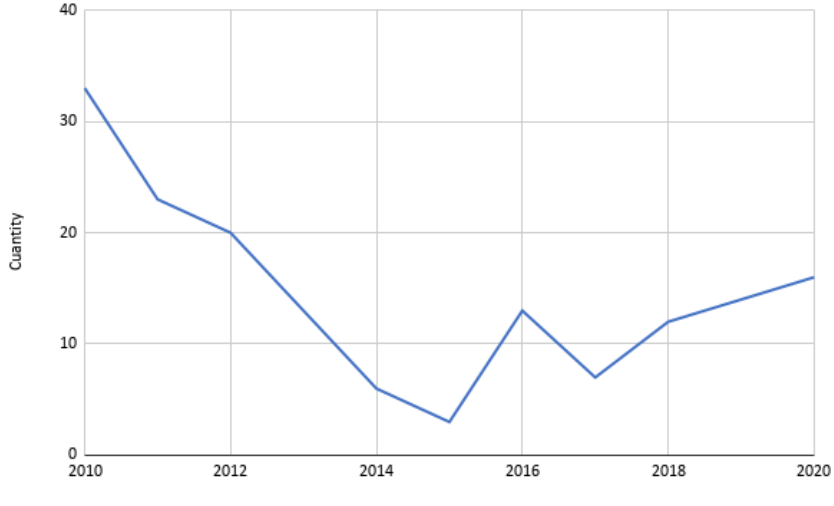
Figure 10. Studies per year.